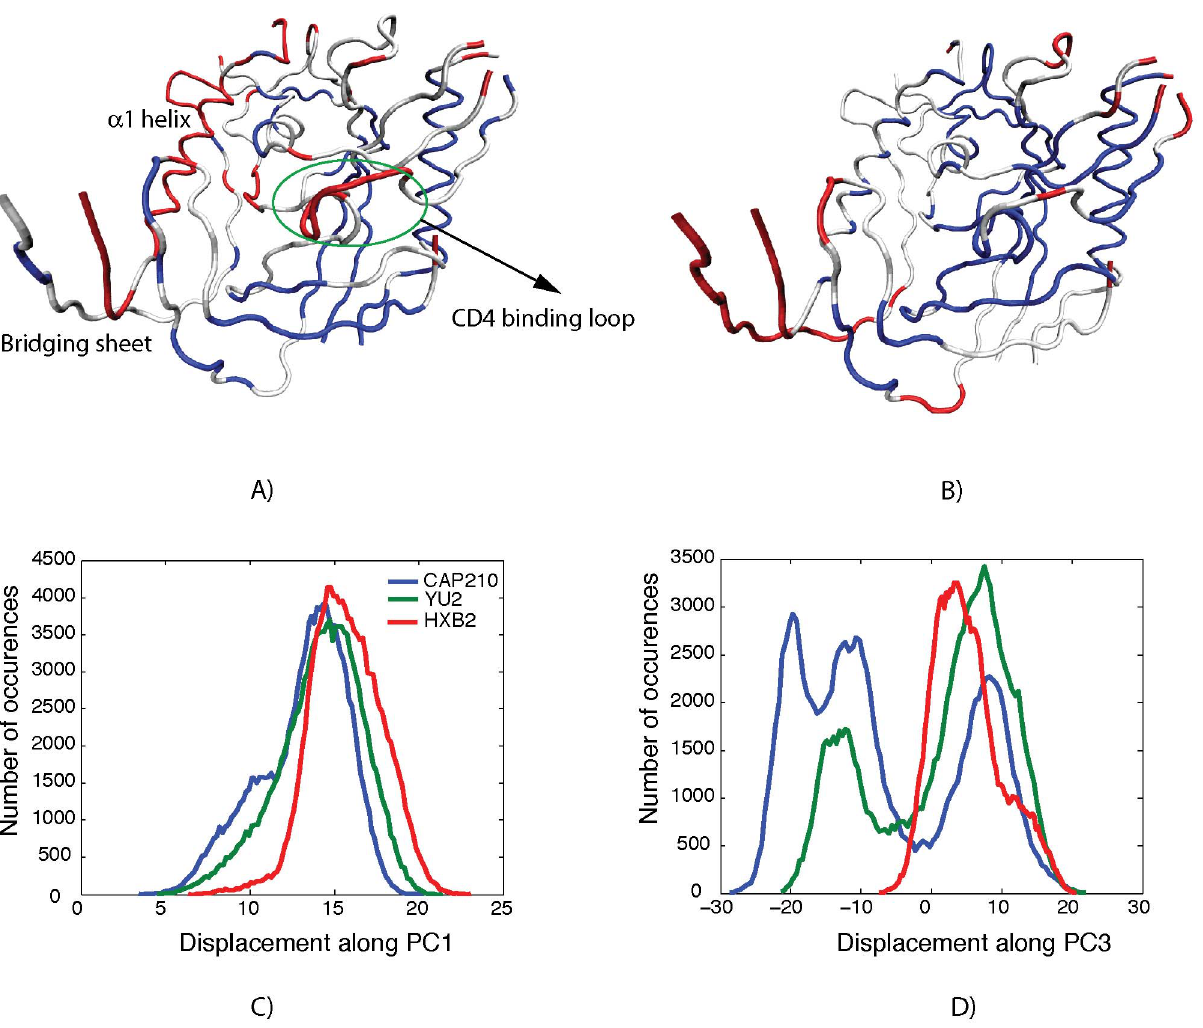
Figure 2. The coupling of motions along (A) PC1 and (B) PC3. Residues that are flexible in the corresponding PC are shown in red, while rigid regions are shown in blue. Regions that display moderate motion in the corresponding PC are shown in white. The histogram of displacement along (C) PC1 and (D) PC3 are also shown.